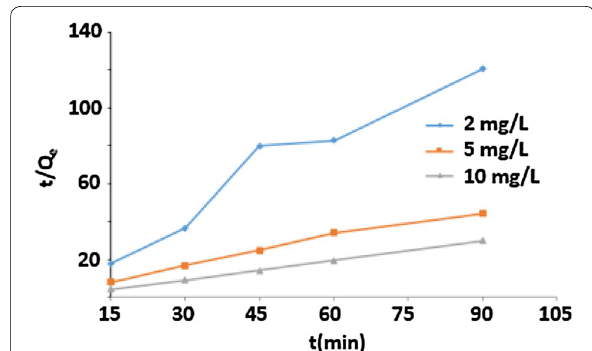
Fig. 14 Plot of second first order kinetic model at 2, 5 and 10 mg/L